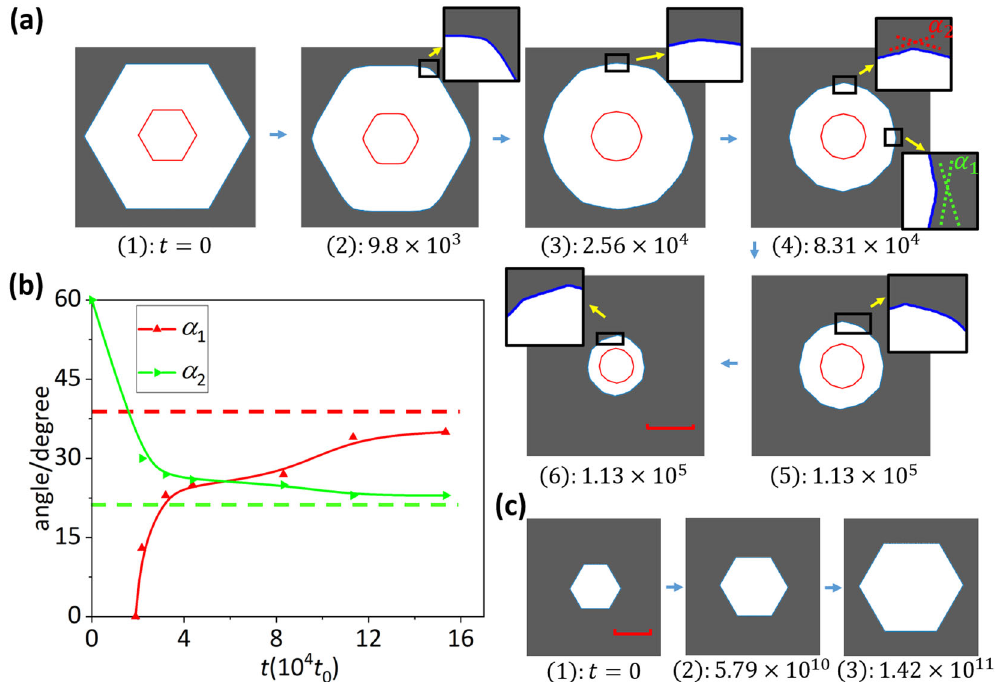
Fig. 5 Growth or etching of a hole in graphene. The KMC conditions were μ = 0.2 eV and k B T = 0.1 eV for growth, and μ = − 0.2 eV and k B T = 0.1 eV for etching. a Growth of a hexagonal hole with all zigzag edges. The red contours are circumferences of a graphene island during etching shown in Fig. 4a, from which one can see that the hole shape evolution during growth is similar to that of island etching. The scale bar is 150 nm for all snapshots. b Evolution of α 1 and α 2 along with the etching time. The dash lines are corresponding angles be of dodecagon with we 19° edges. c The evolution of a hole during graphene